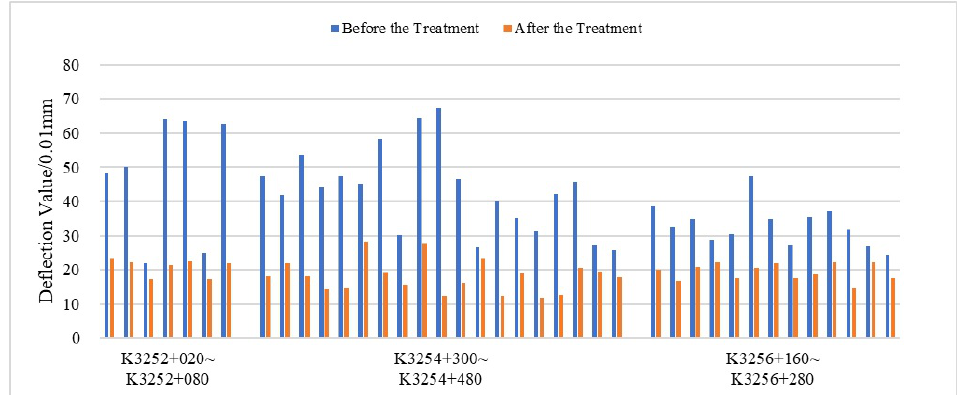
Fig. 6 Distribution of deflection value of the Benkleman Beam Deflectometer before and after the old pavement disease